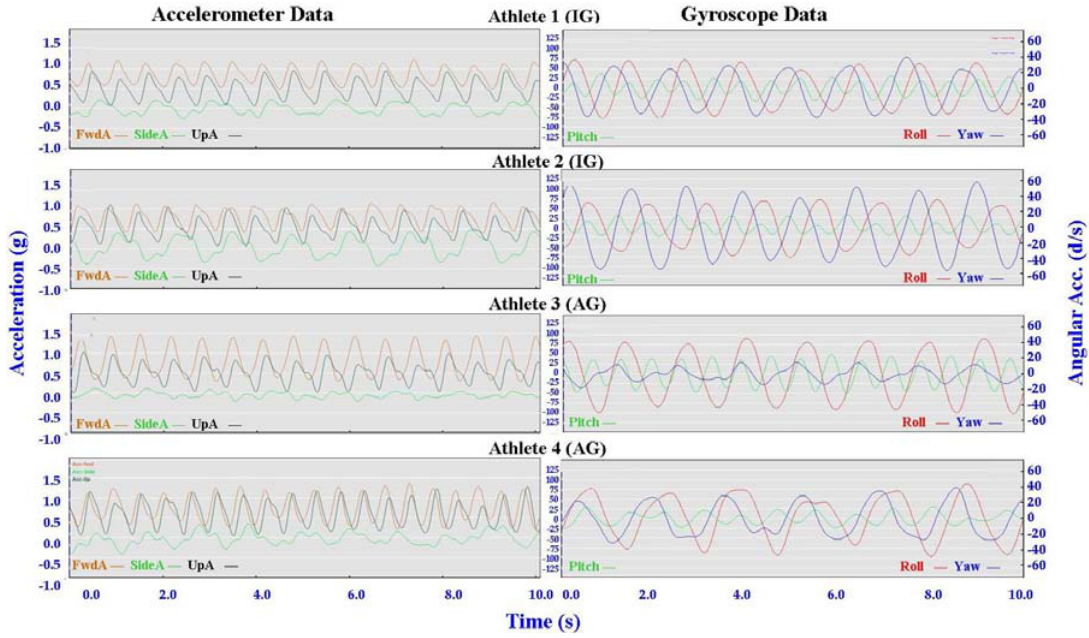
Figure 12. Comparison of Diagonal Stride (DS) gyroscope and accelerometer traces for four athletes (two from the IG and two from the AG).